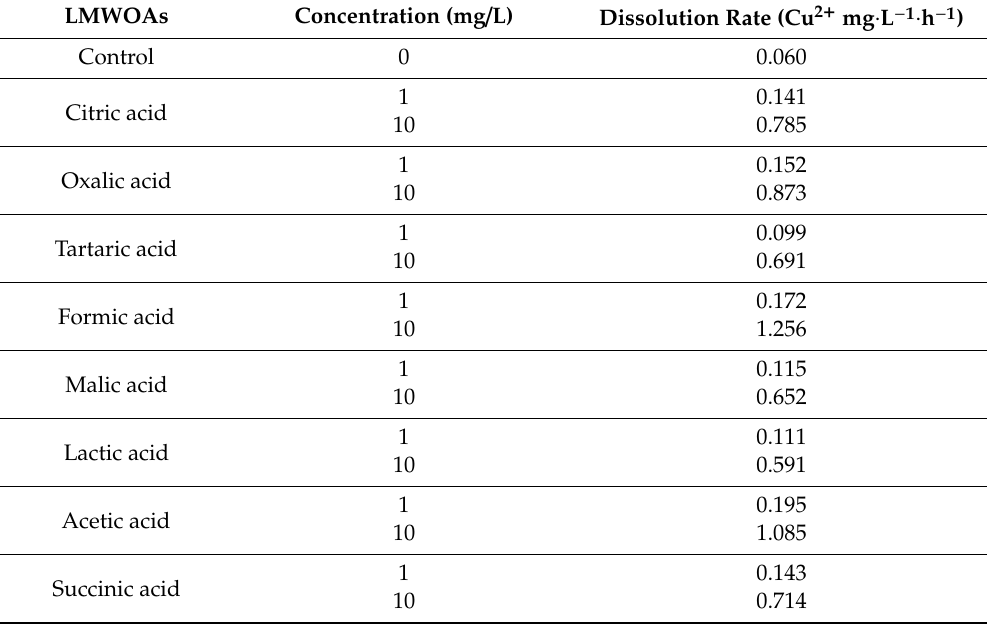
Table 2. Dynamic fitting of CuO NP dissolution with di ff erent LMWOAs contents in aqueous solution.